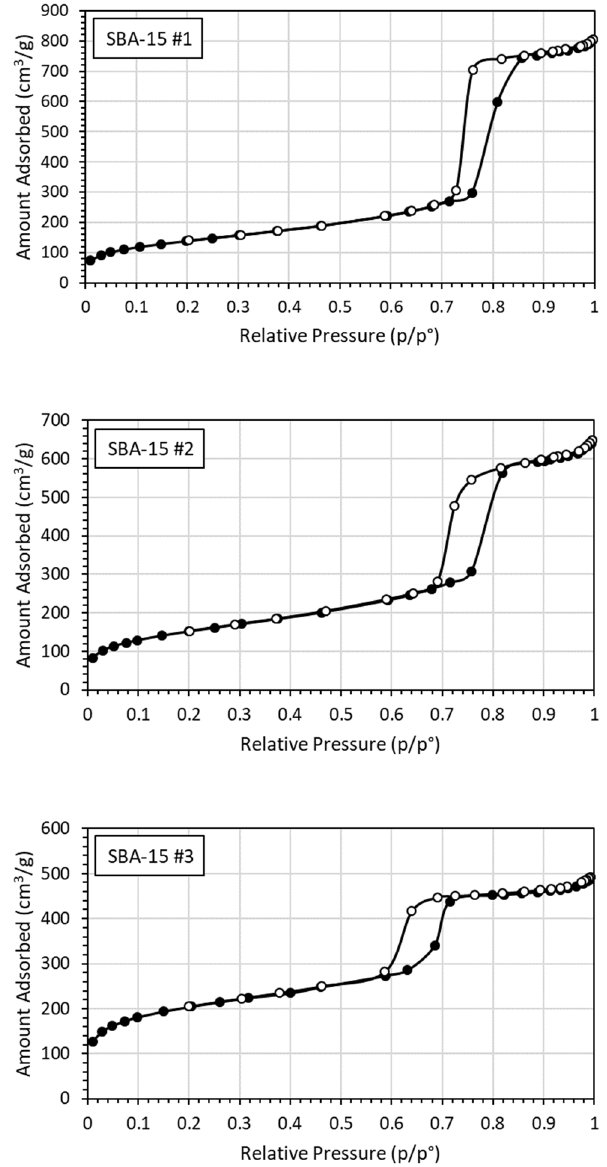
Figure 1. Nitrogen adsorption isotherms for SBA-15 mesoporous silica. Filled and open symbols represent the adsorption and desorption phases of the measurement, respectively. Table 1. Geometric properties for the mesoporous silicas. BJH pore diameters are measured from